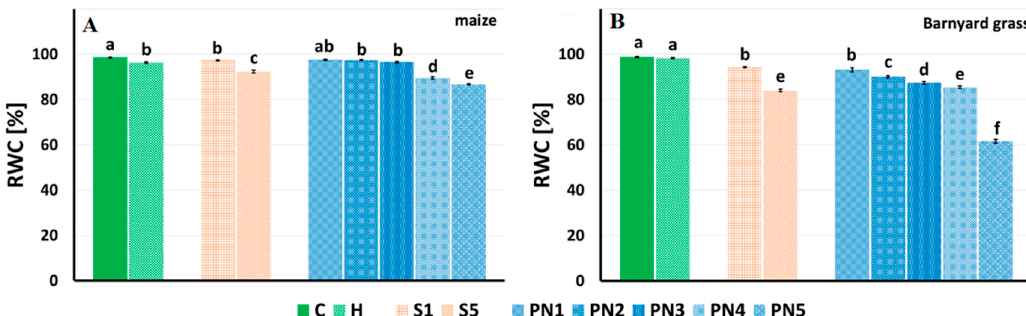
Figure 9. Relative water content (RWC) of maize ( A ) and barnyard grass ( B ) that were growing on the surfactants S1 (1% v / v ) and S5 (10% v / v ), nanoemulsions with peppermint oil PN1 (1% v / v ), PN2 (1.5% v / v ), PN3 (2% v / v ), PN4 (5% v / v ), and PN5 (10% v / v ), herbicide (H) and water (C) calculated as (fresh mass—dry mass)/(turgid mass—dry mass)] × 100. The letters a–f indicate statistically significant differences. Values indicated by the same letters did not differ significantly at p ≤ 0.05 ac- cording to Duncan’s test (within the tested species), n = 10.